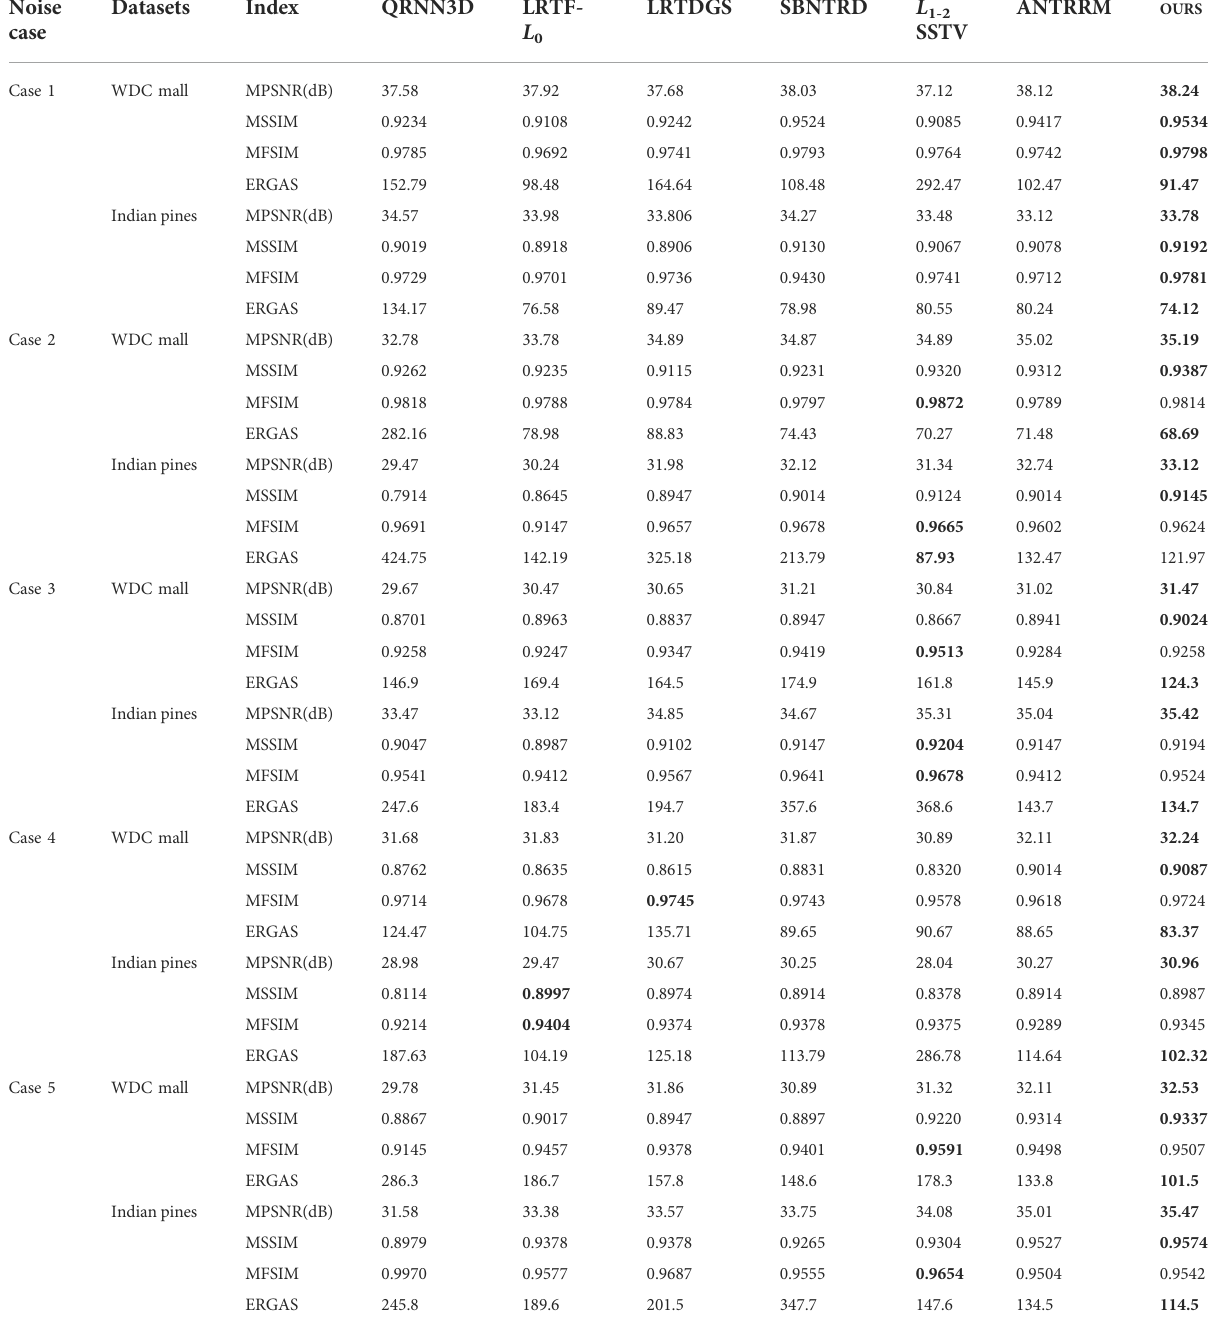
TABLE 1 Quantitative results of all the methods under different noise cases FOR WDC and urban DATASETs. Noise case